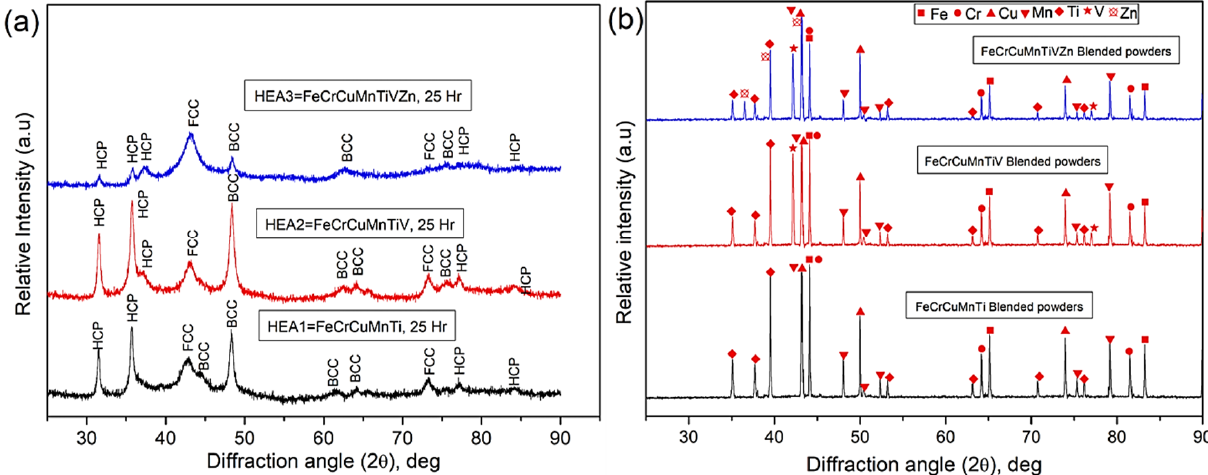
Figure 2. XRD patterns of different equiatomic high-entropy alloys powders of FeCrCuMnTi (HEA1), FeCrCuMnTiV (HEA2), and FeCrCuMnTiVZn (HEA3) synthesized by MA: ( a ) 25 h; ( b ) 0 h blended samples for comparison.